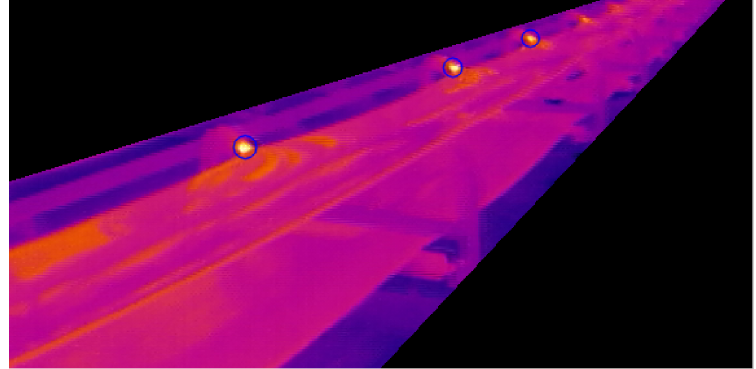
Figure 13. Result of damaged idler detection, example